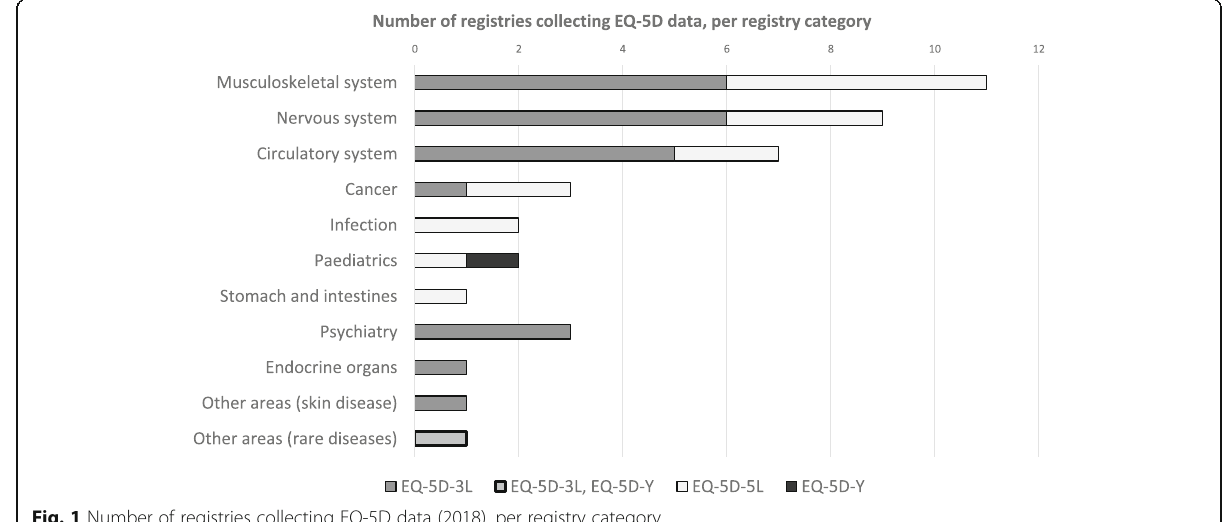
Fig. 1 Number of registries collecting EQ-5D data (2018), per registry